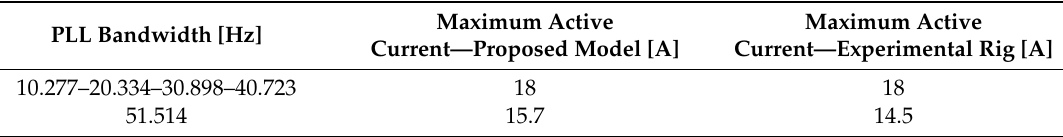
Table 4. Comparison between proposed model and experimental system for SCR = 1.8577. PLL Bandwidth [Hz]